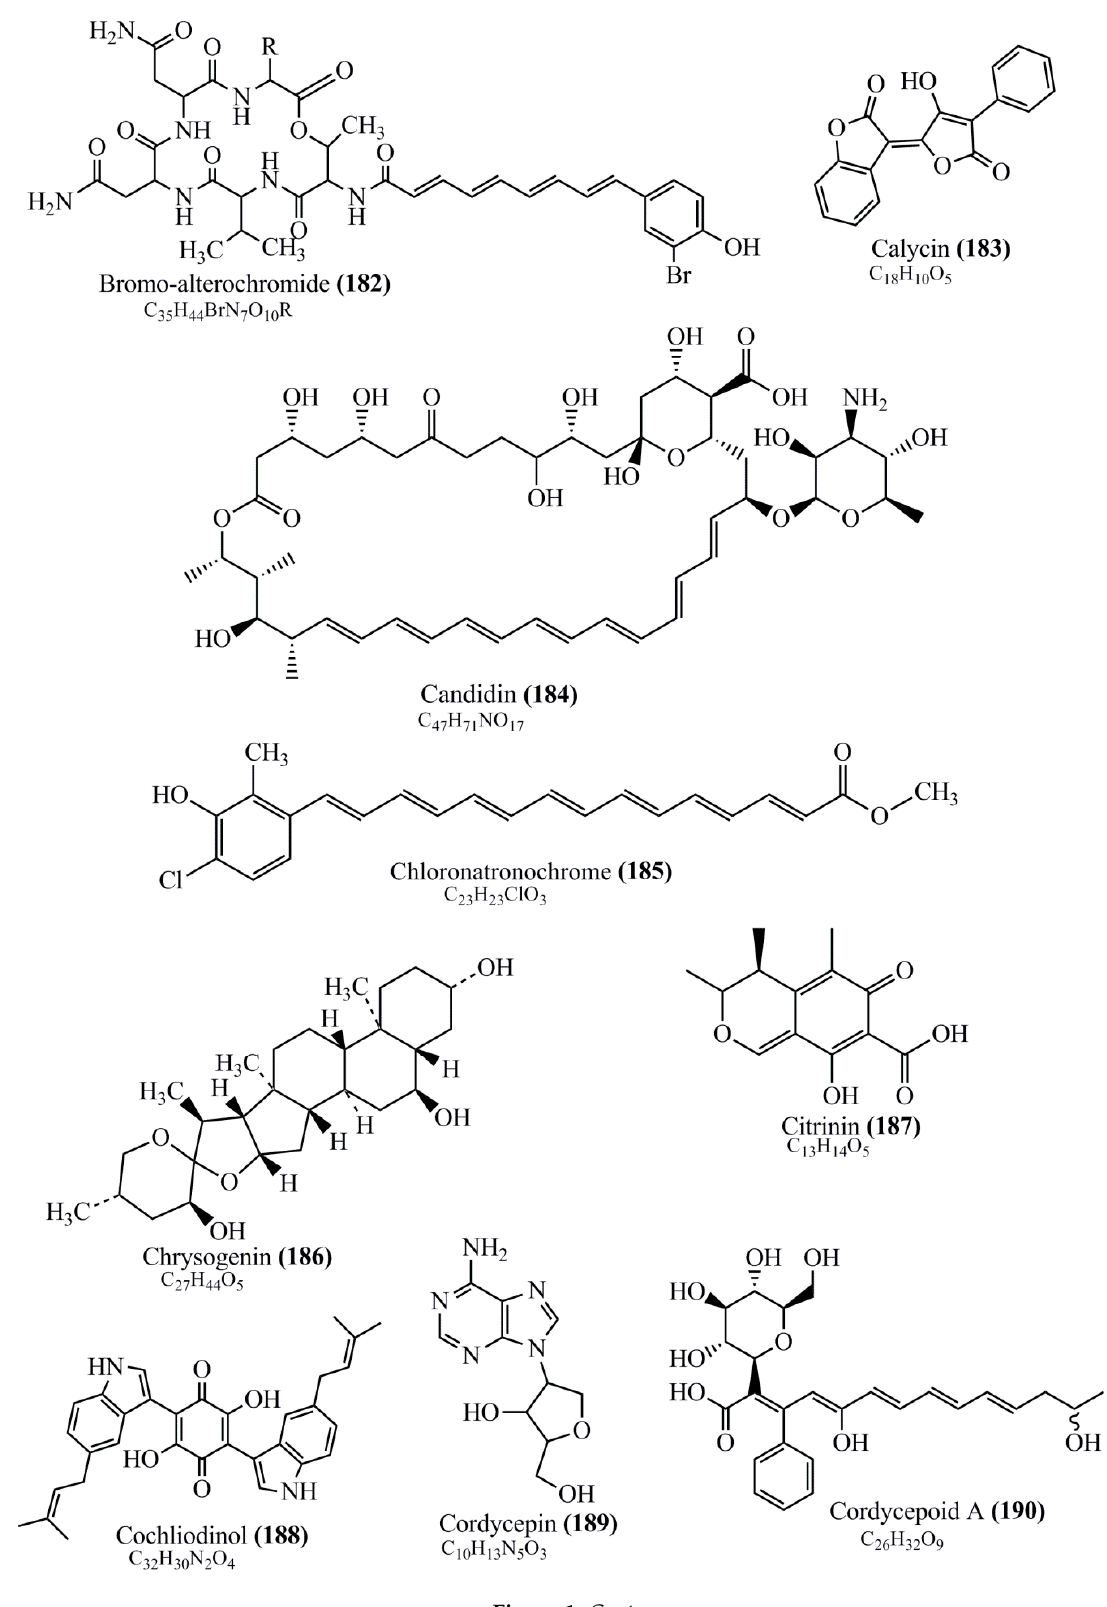
Figure 1. Continued. Figure 1.